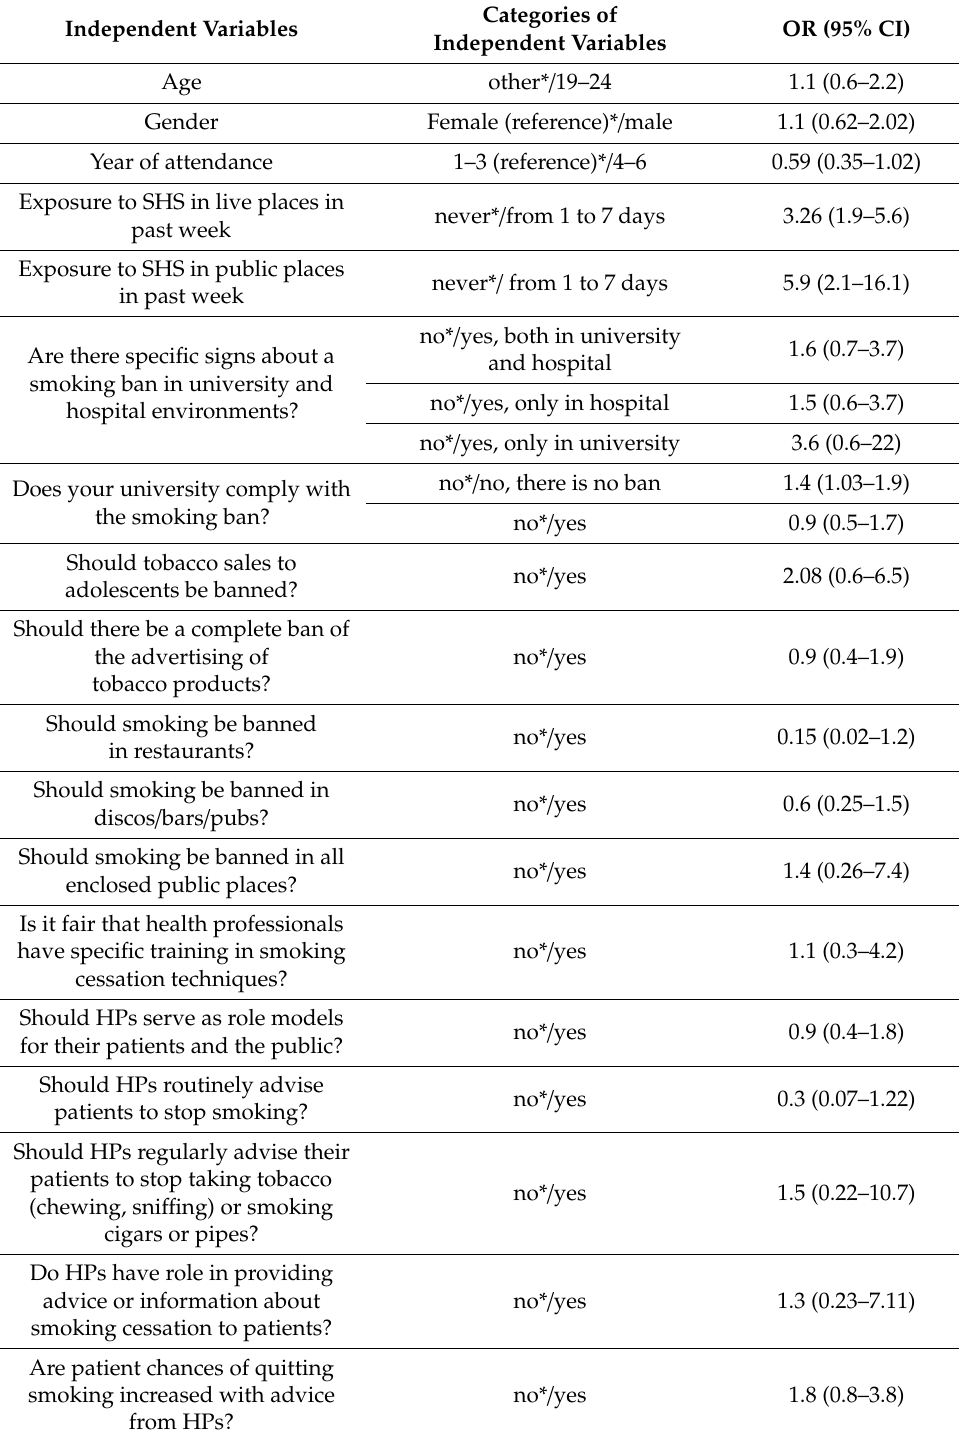
Table 4. The association between being a smoker and the potential risk factors using multivariate logistic